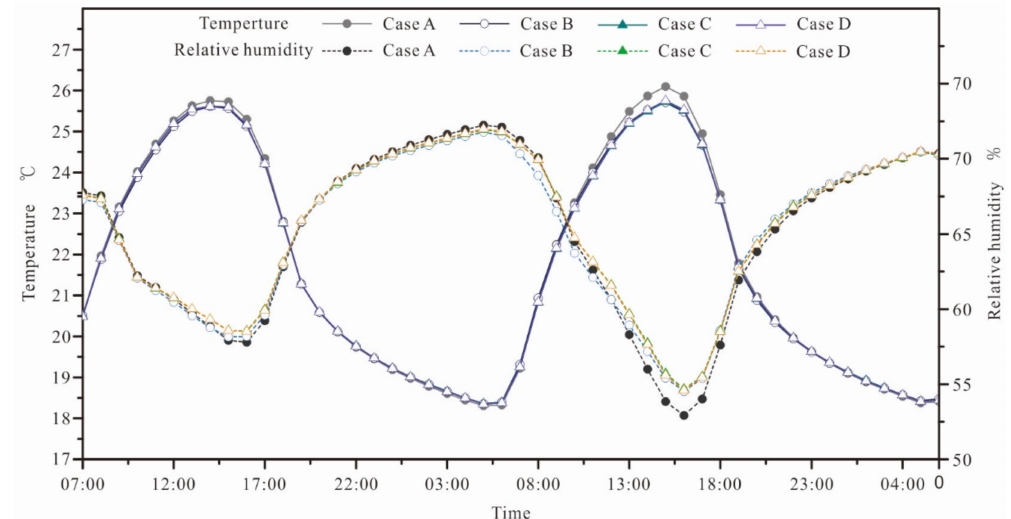
Figure 5. Temporal profile of temperature and relative humidity at point P.